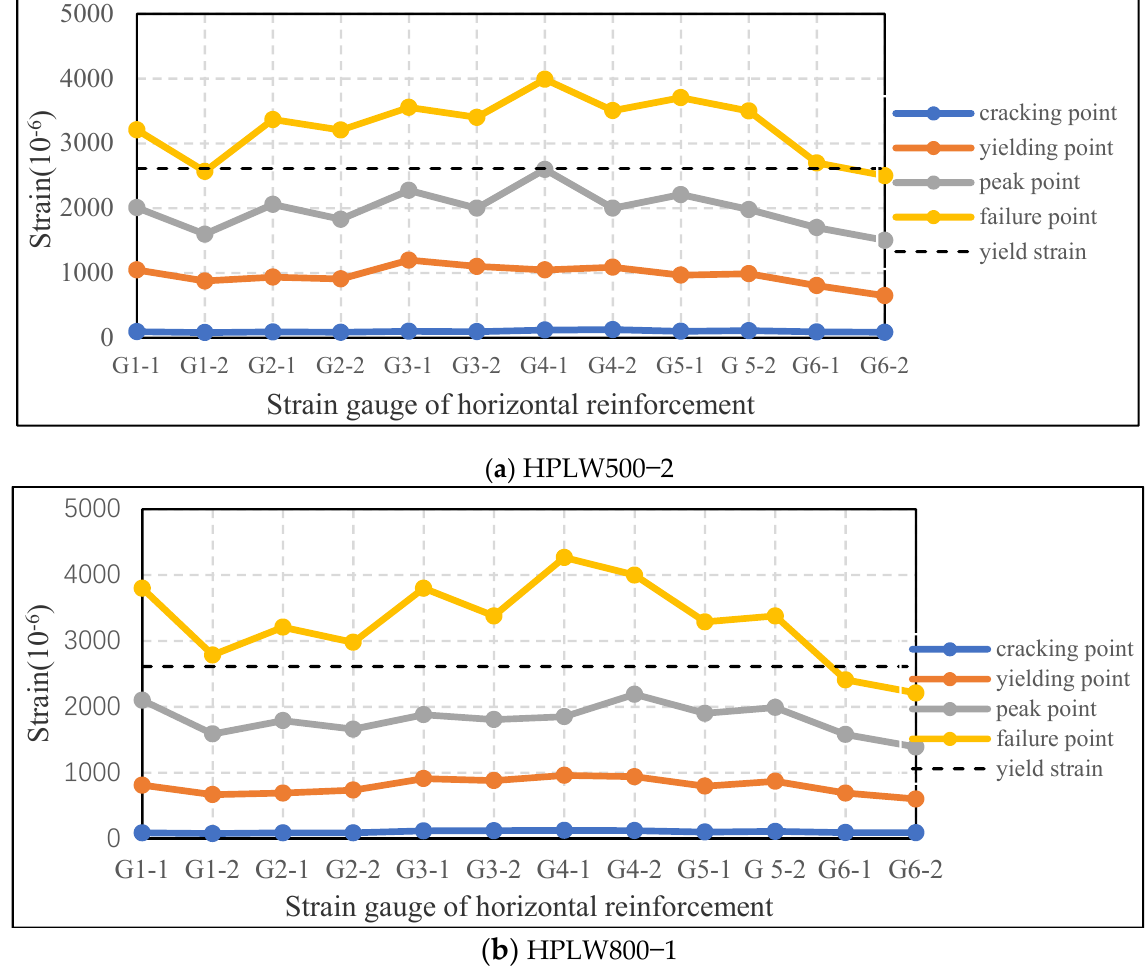
Figure 15. Horizontal reinforcement strain distributions along the wall height.